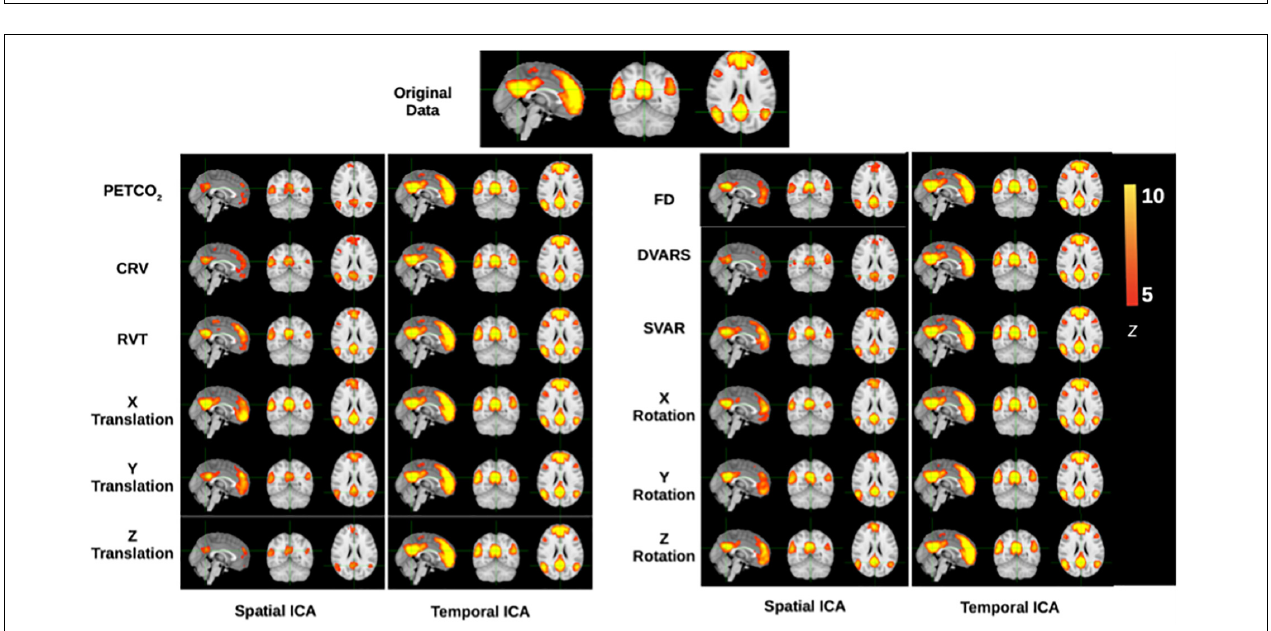
FIGURE 8 | Functional-connectivity patterns associated with the denoised signals. Each row corresponds to the group-average TBR-based connectivity maps associated with signals that had specific noise correction applied to it. At the top is shown the DMN connectivity map obtained from the original data, and denoised data should maximally display DMN structure, which is generally stronger in tICA-cleaned signals.